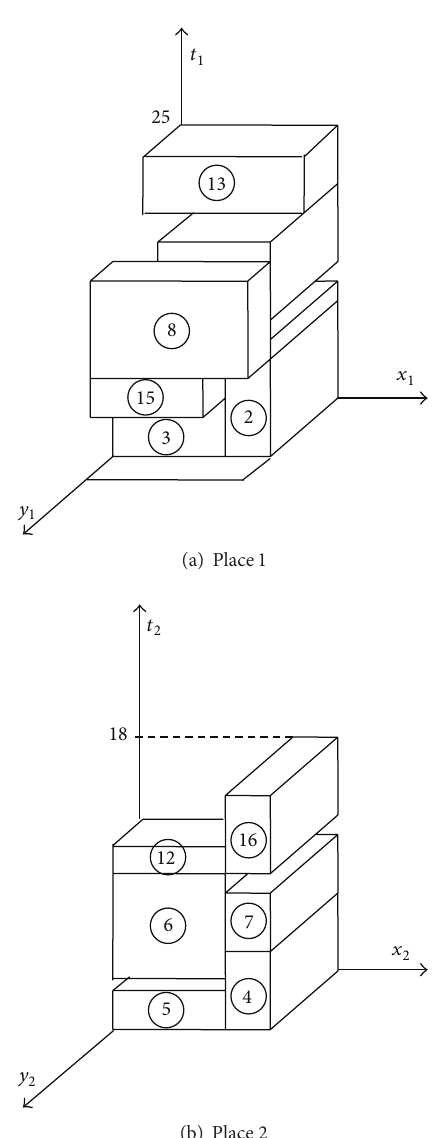
Figure 8: The status while all activities are